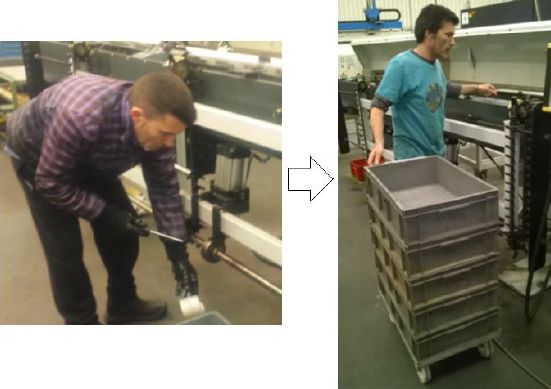
Figure 11. Operator performing the activity of replacing the gutters from the machine before and after the implementation of the tray cart (Posture